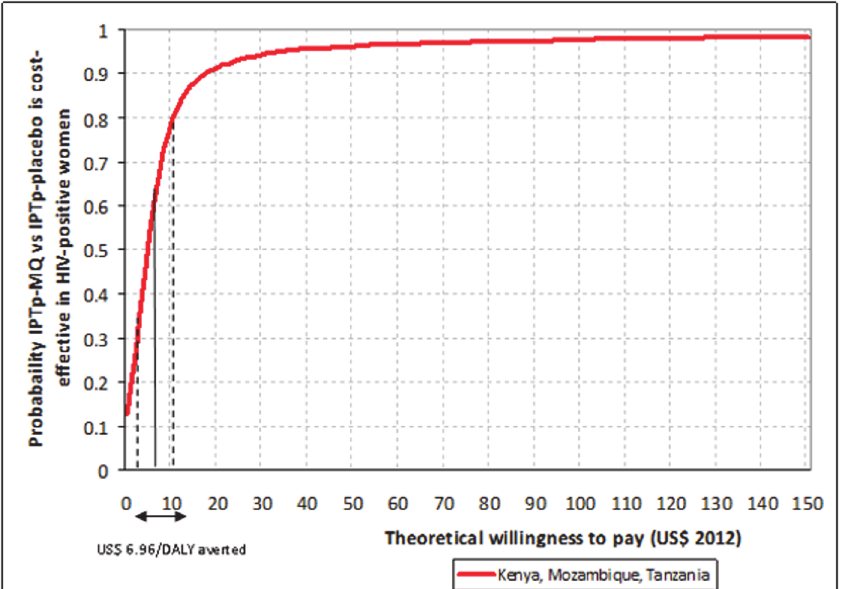
Fig 6. Cost-effectiveness of IPTp-MQ versus IPTp-Placebo in HIV-positive pregnant women in Kenya, Mozambique and Tanzania: acceptability curve. IPTp-MQ = Intermittent Preventive Treatment of malaria in pregnancy with Mefloquine; HIV = Human Immunodeficiency Virus; DALYs = Disability-adjusted life years. The acceptability curve was constructed by plotting the cumulative distribution of the incremental cost- effectiveness ratio (ICER) of IPTp-MQ compared with IPTp-Placebo per DALYs averted. The Y axis is interpreted as probability that the intervention is cost-effective for every level of policy makers ’ willingness to pay for each DALY averted (X axis). US$ 6.96 per DALY averted (CI95% 4.22 – 9.70) is the ICER resulting from the analysis.